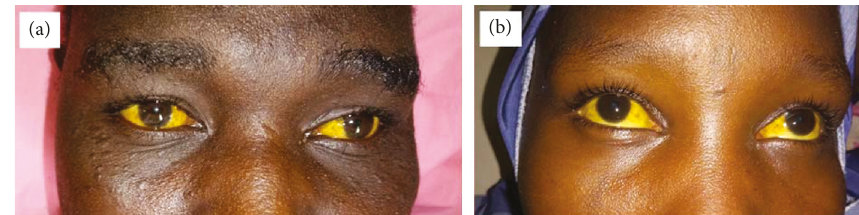
Figure 1: Conjunctival jaundice found in